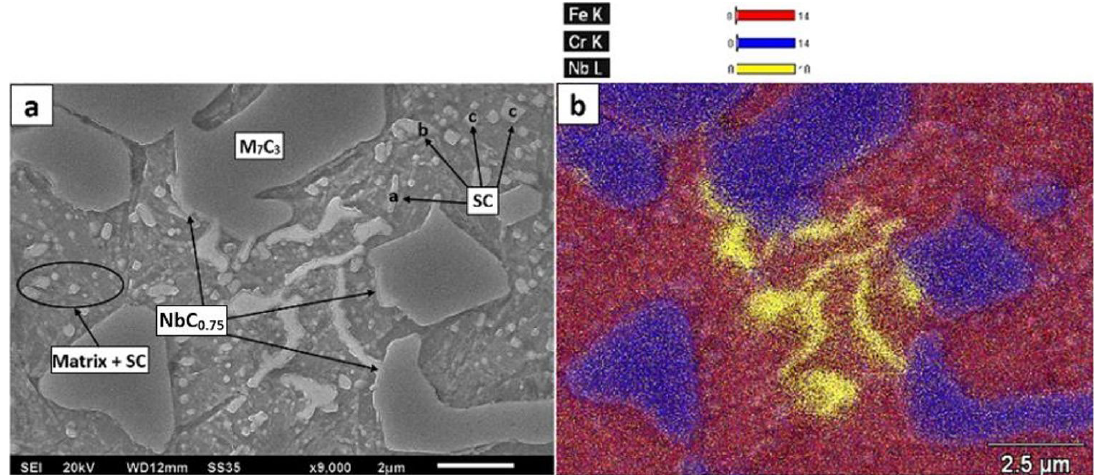
Figure 6. Microstructure of the HCCI1%Nb alloy (a) SEM; and (b) chemical